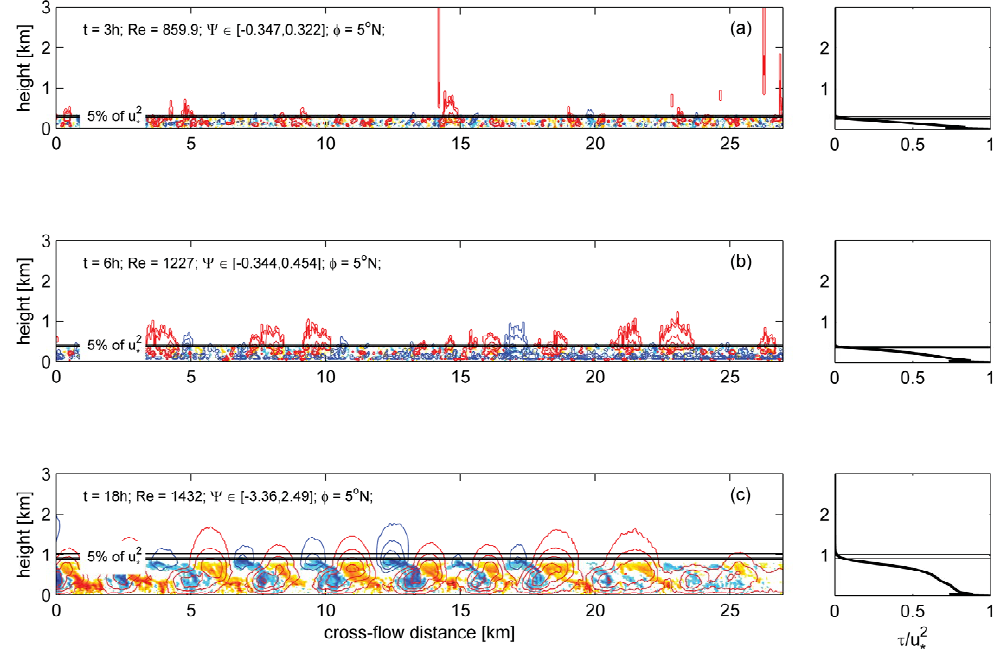
Fig. 8. Cross-flow sections ( yz planes) of the instant flow patterns in WE-EBL at 5 ◦ N. The patterns are given at the beginning (after 3h of LES integration at the upper panel) and the end (after 6h at the middle panel) of the linear growth stage as well as for the quasi-stationary stage (after 18h at the bottom panel). Contours represent the anomalies flow stream function from Eq. (30), with negative values shown as dashed contours. The color shading represents the anomalous flow velocity from Eq. (29), with blue corresponding to the slow motions. The time of the snapshots, the EBL Re at that time and the range of the stream function values are indicated on the panels. The horizontal lines show the EBL depths h 10 (the lowest line), h PBL and h 1 (the highest PBL PBL